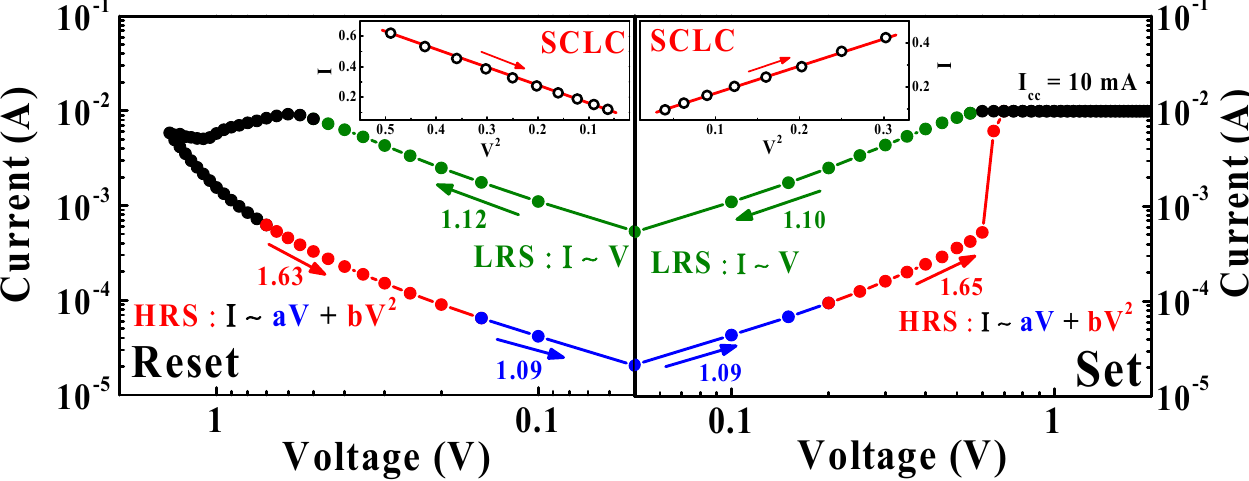
Figure 5. Double-logarithmic plots of the BRS I - V curves of the SPE-chitosan memristor. The blue and red lines on the HRS curve represent the linear and quadratic relations, respectively, and the green line on the LRS curve represents a linear relation. The insets are the I-V curves of the HRS at high voltage, which are well-fitted by the space-charge limited conduction (SCLC) mechanism.